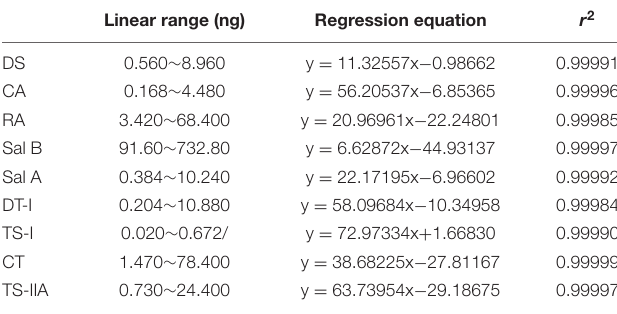
TABLE 2 | The calibration curve data of reference substance in S. miltiorrhiza root ( n = 6). Linear range